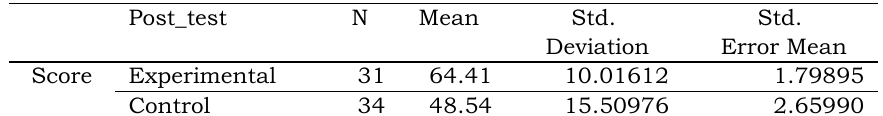
Table 5. Independent Sample Post-test In Control and Experimental